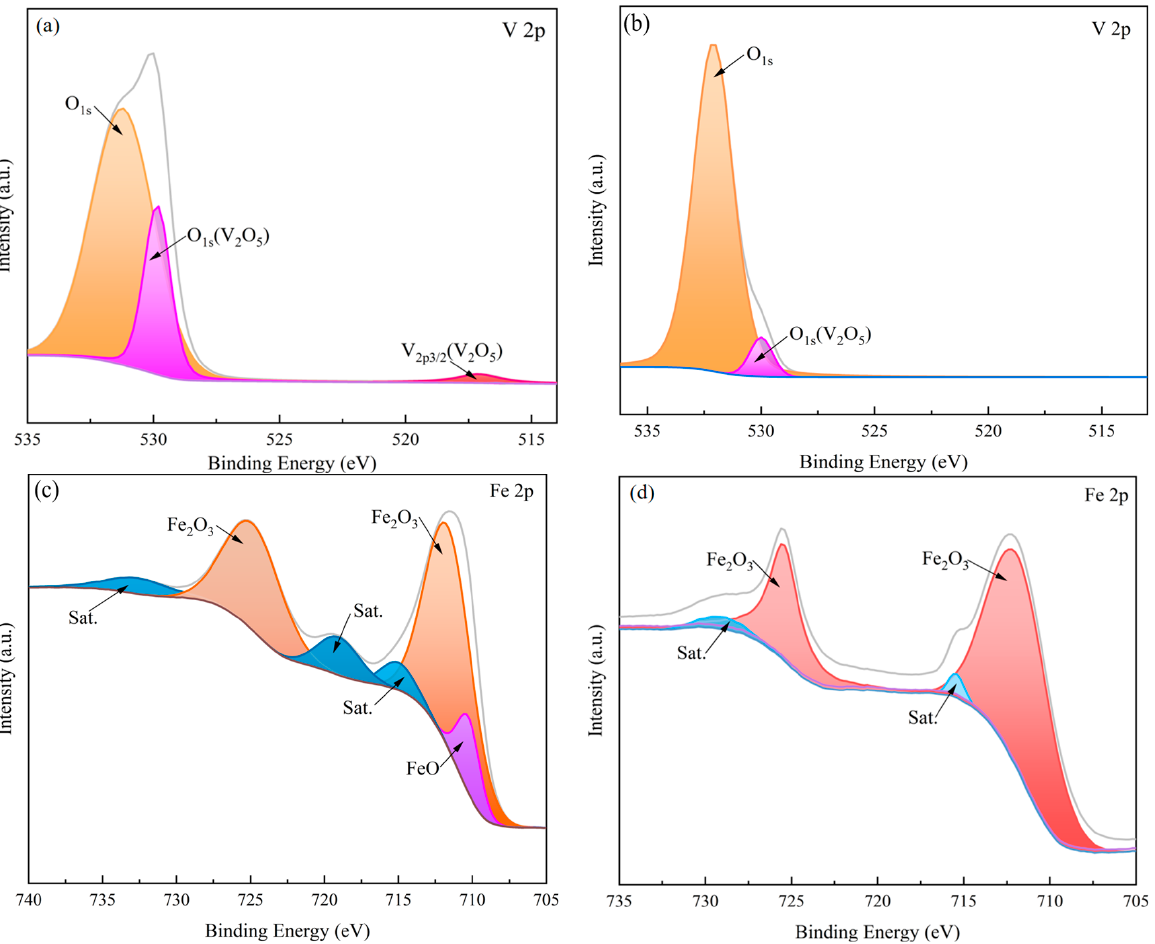
Figure 6. XPS patterns of ( a ) V 2p (roasted pellets), ( b ) Fe 2p o(roasted pellets), ( c ) V 2p (leaching pellets), ( d ) Fe 2p o(leaching pellets).